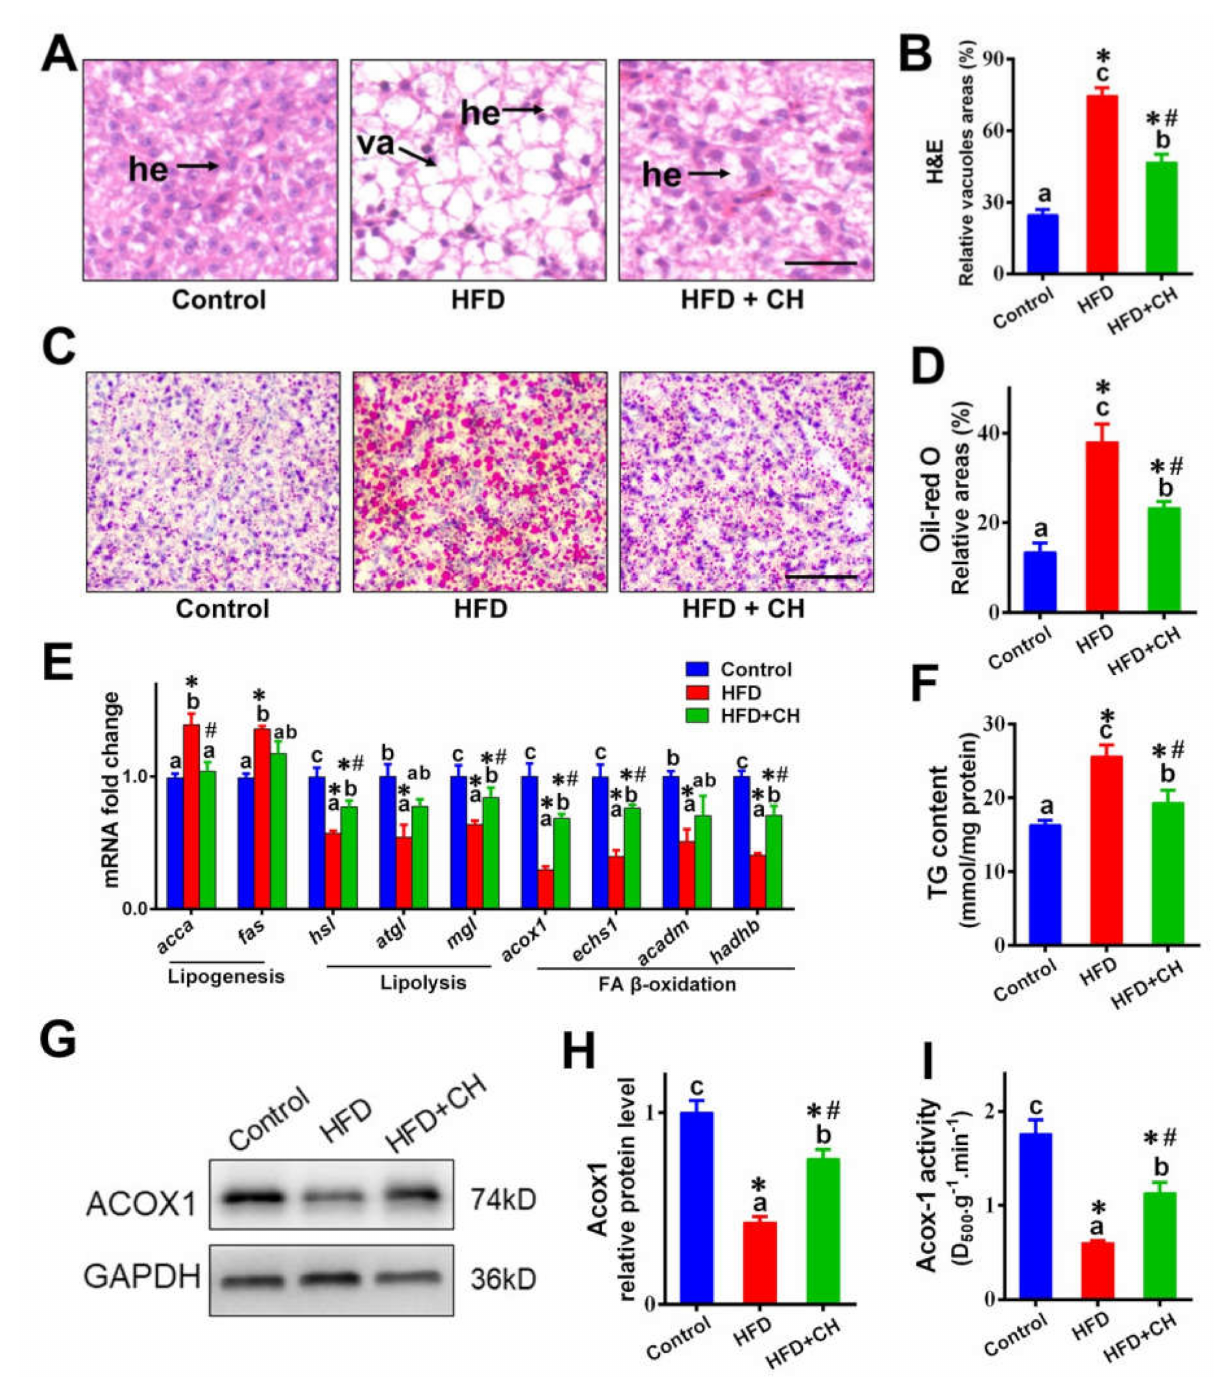
Figure 1. Dietary choline attenuated high-fat diet (HFD)-induced hepatic lipid dysregulation of yellow catfish. ( A ) Representative images of liver H&E staining. Scale bar, 30 µ m, hepatocytes (he), vacuoles (va). ( B ) Relative areas for hepatic vacuoles in H&E staining. ( C ) Representative images of liver Oil Red O staining. Scale bar, 30 µ m. ( D ) Relative areas for LDs in Oil Red O staining. ( E ) The mRNA levels of the genes related to hepatic lipid metabolism. ( F ) Hepatic TG content. ( G , H ) Western blot analysis and quantification analysis of ACOX1. ( I ) Activities of ACOX1 enzymes. Data are mean ± SEM ( n = 3 replicate tanks), different letters indicate significant differences among groups, asterisks * indicate significant differences between control and HFD/or HFD + CH, and pound # indicates significant differences between HFD and HFD + CH ( p ≤